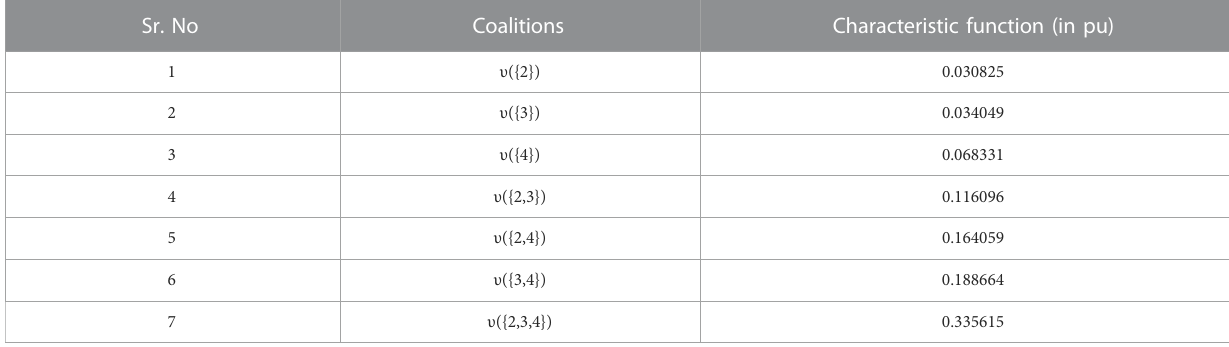
TABLE 1 Characteristic function of 4-bus